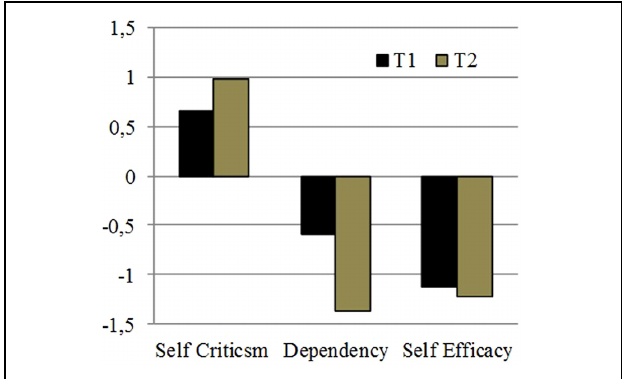
FIGURE 5 | The Depressive Experience Questionnaire (DEQ) dimensions at the beginning of the psychotherapy and after 1